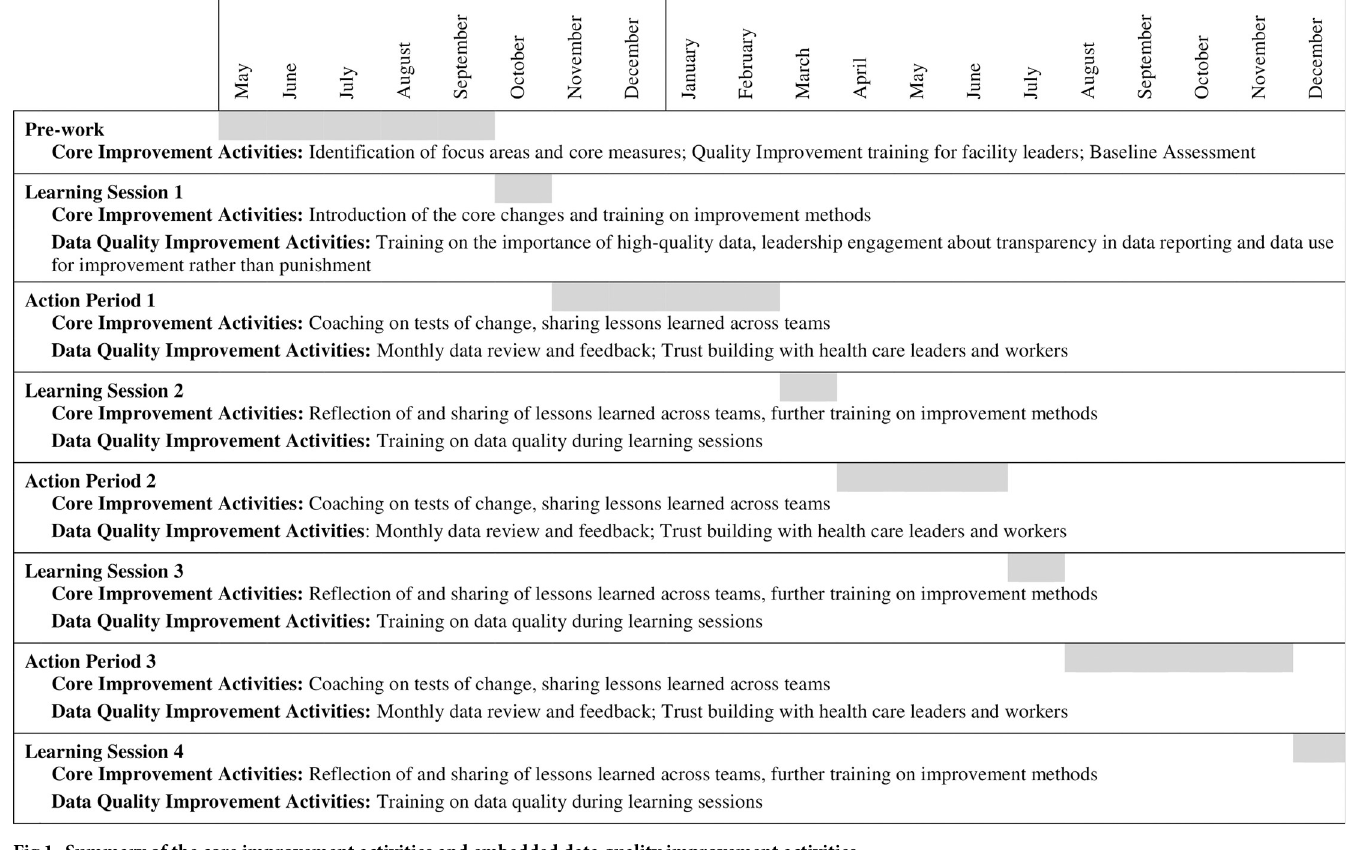
PLOS ONE | https://doi.org/10.1371/journal.pone.0237703 August 14,